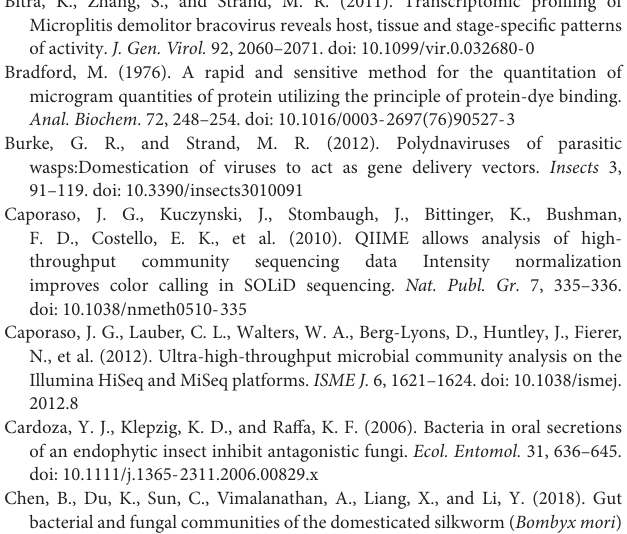
Supplementary Figure 1 | Parasitism increased the bacteria load in the oral secretion of fall armyworm larvae. Supplementary Figure 2 | Rarefaction curves of larval gut samples. Supplementary Figure 3 | Venn diagram of the shared and unique OTUs between parasitized larvae and non-parasitized larvae. Supplementary Figure 4 | Non-metric multidimensional scaling (NMDS) analysis. Supplementary Table 1 | List of primers for quantitative real-time PCR for maize. Supplementary Table 2 | OTU and sequence number in individual sample. Supplementary Data Sheet 1 | R script for ANOSIM and PERMANOVA. Supplementary Data Sheet 2 | Preparation of both wheat germ diet and pinto bean diet. Supplementary Data Sheet 3 | Detailed information of OTU distribution and taxonmy in individual